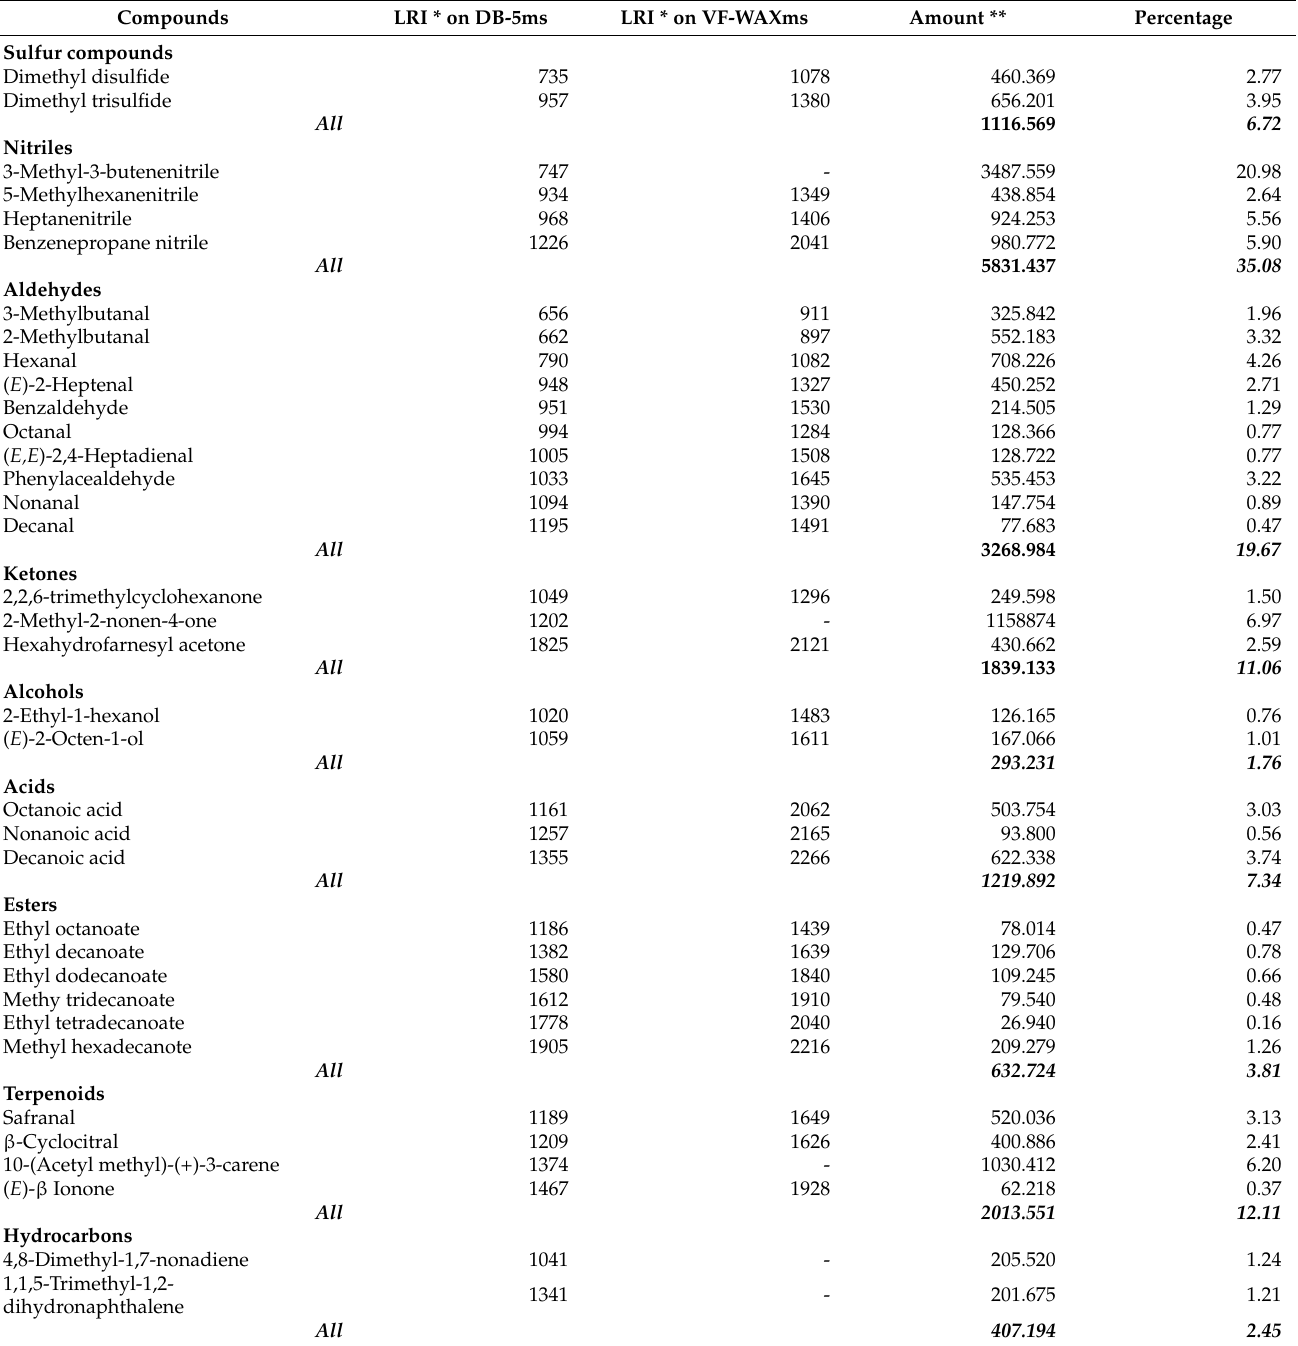
Table 2. Composition as volatile constituents and classes of substances of B. fruticolosa subsp. fruticu- losa leaf hydroalcoholic